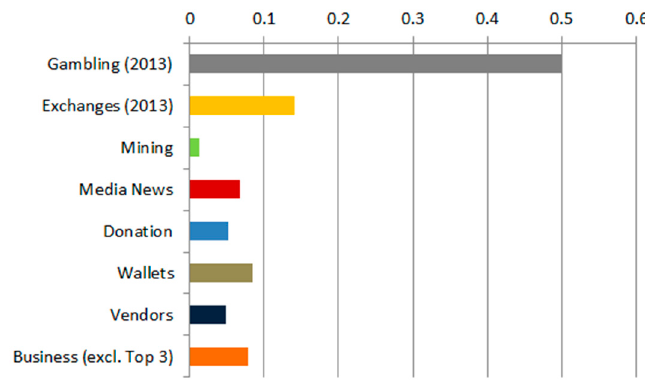
Figure 34. Average Clustering Coefficient for Business Categories.